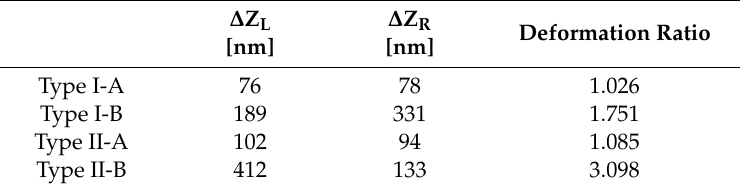
Table 2. Deformation ratio of both proof masses due to